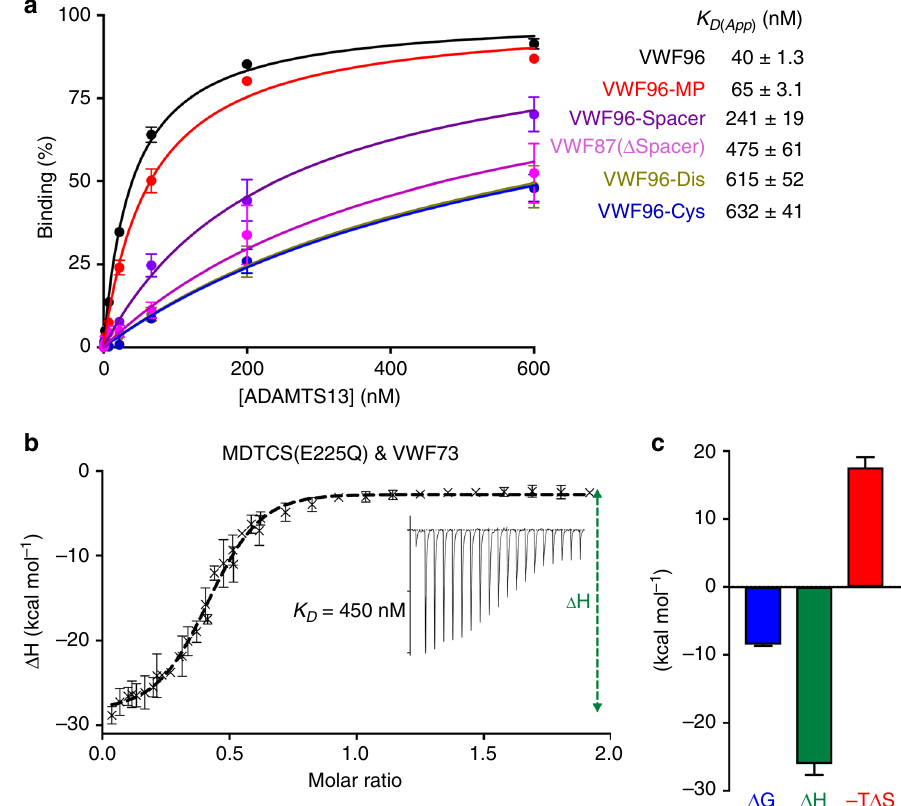
Fig. 3 Binding of ADAMTS13 to Von Willebrand factor (VWF) A2 domain fragments. a Plate binding of ADAMTS13 to VWF96 variants. VWF96, and variants thereof, were adsorbed onto 96-well microtiter plates and incubated with increasing concentrations of ADAMTS13 (0 – 600 nM) for 1 h. Wells were washed and ADAMTS13 binding detected using an anti-ADAMTS13 TSP2 – 4 polyclonal antibody. Each concentration was assayed in duplicate on each plate and the data presented are mean ± SEM of three separate experiments. Data were fi tted and the K D(App) derived for ADAMTS13 binding to